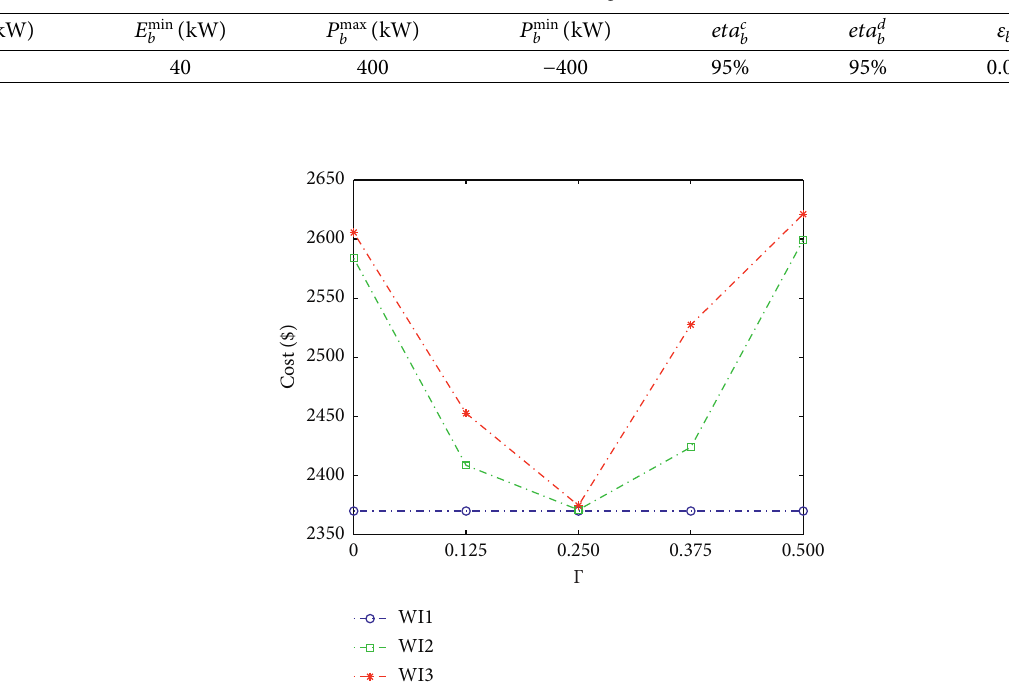
Figure 4: Comparison of the operation cost between RMPC method and traditional MPC.